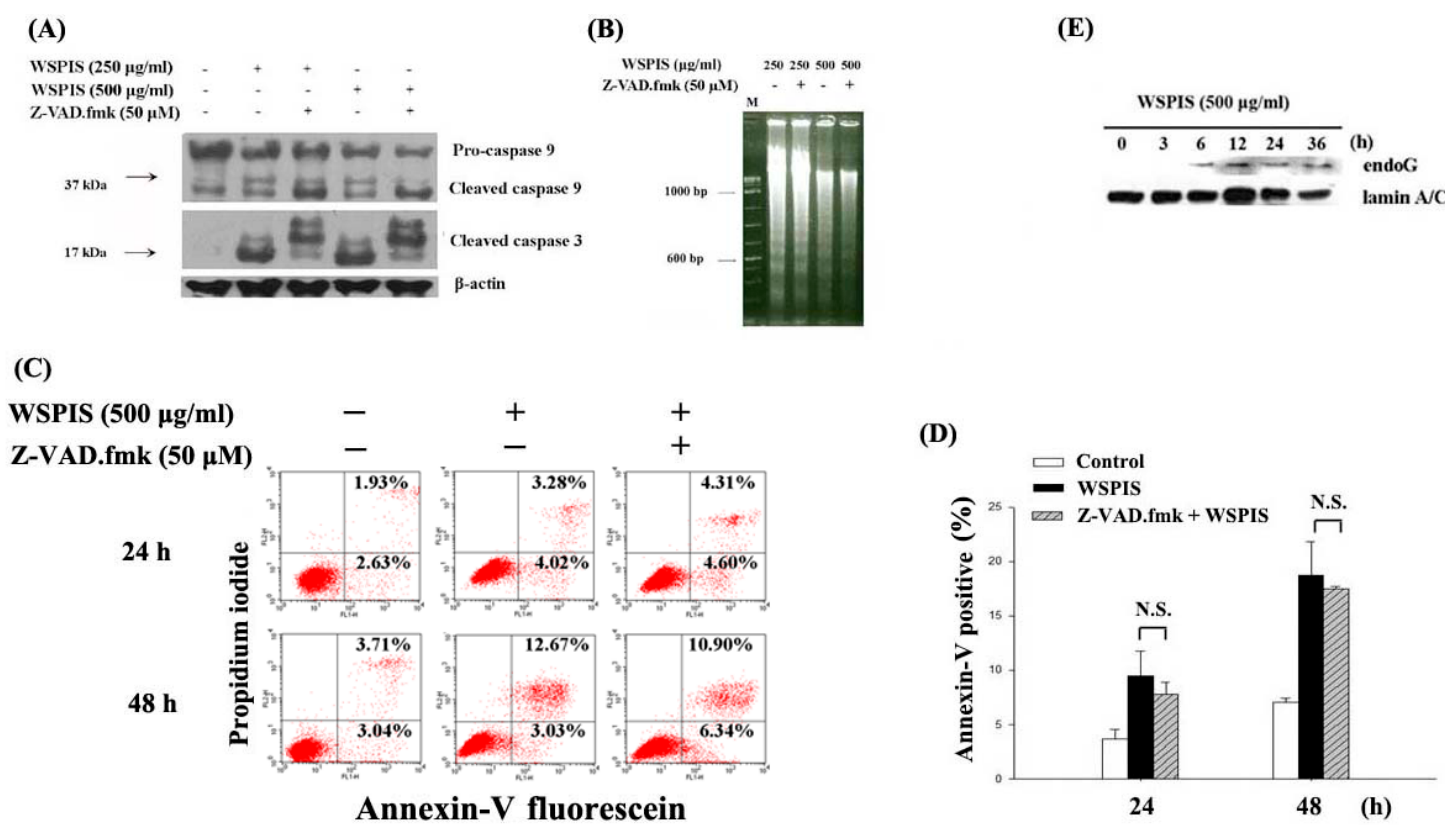
Figure 5. Caspase-independent apoptosis in WSPIS-treated THP-1 cells. ( A – D ) Cells were pretreated with or without Z-VAD.fmk (50 µ M) for 1 h followed by WSPIS treatment for 24 and 48 h. ( A ) Cleaved products of caspase-3 and caspase-9 (17 and 37 kDa, respectively) were measured by Western blotting. ( B ) Oligonucleosomal DNA fragmentation was determined by agarose gel electrophoresis. M is the DNA markers. ( C ) Apoptotic cells (annexin-V-positive) were analyzed using flow cytometry after annexin-V/propidium iodide staining. ( D ) Apoptotic cells are expressed as mean ± SD of three independent experiments. N.S. = Not significant. ( E ) Nuclear translocation of endoG. Cells were treated with 500 μ g/mL WSPIS for the indicated time periods. The levels of nuclear endoG were determined by Western blotting. Results are representative of three independent experiments.